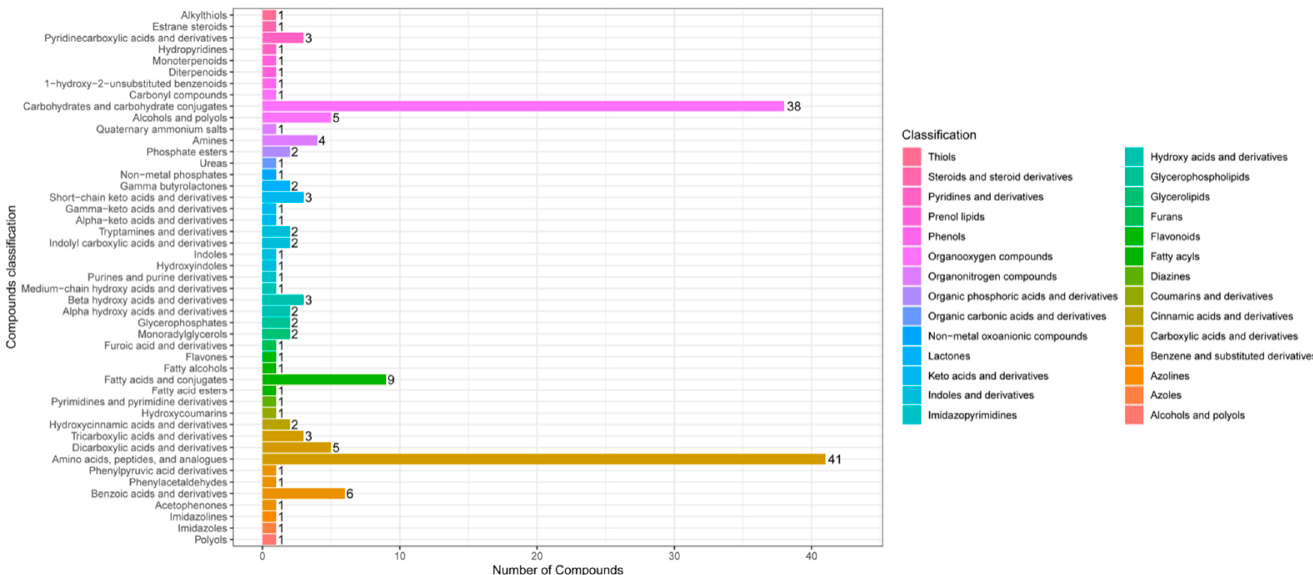
Figure A1. Multivariate statistical analysis of differential metabolites from PSP storage roots under 60% shading treatment and control, including PCA, OPLS-DA and PLS-DA. Green and blue cir- cles and red triangles reflected the 60% shading and non-shading samples and three QC sample (n = 3), respectively. Analysis represents with eight independent replicates (n = 8). principal compo- nent analysis, PCA, orthogonal partial least-squares discriminant analysis, OPLS-DA, partial least- squares discriminant analysis, PLS-DA.